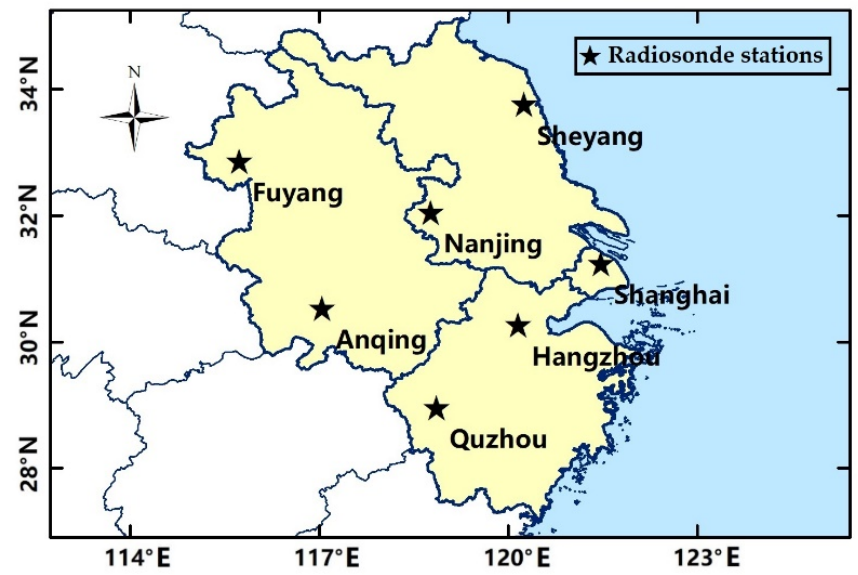
Figure 1. Distribution map of radiosondes in the Yangtze River Delta region.